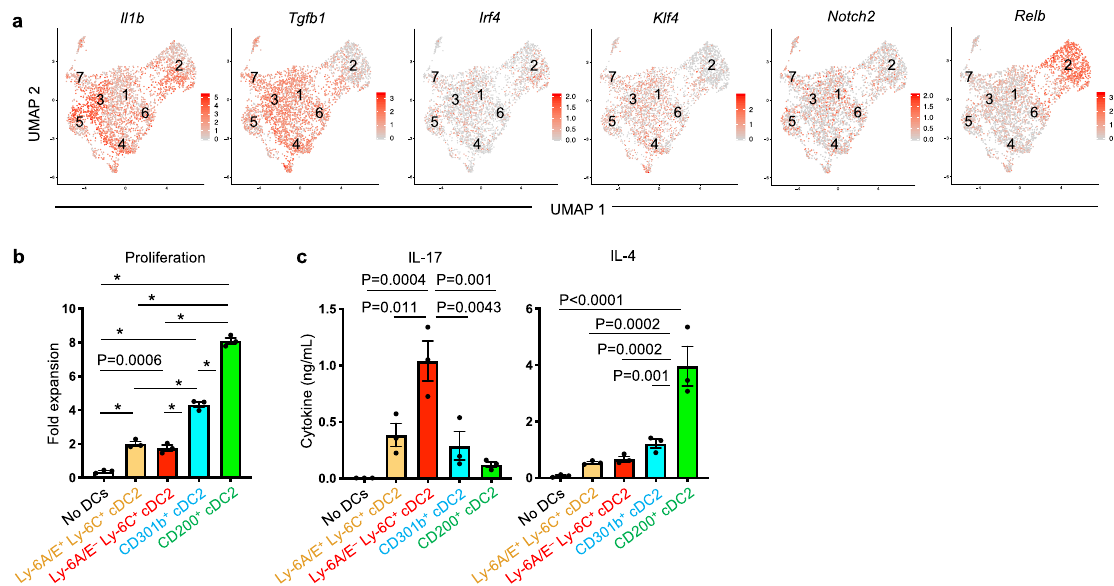
Fig. 8 Select CD11b + cDC2 subpopulations stimulate Th17 differentiation. a UMAP plots showing expression of genes encoding factors potentially regulating Th2 or Th17 cell differentiation in cDC2 clusters analyzed by scRNA-Seq. Expression levels are indicated by color difference and bars. b , c Proliferation ( b ) and IL-17 and IL-4 production ( c ) of OT-II CD4 + T cells stimulated by the indicated cDC2 subpopulations. The gating strategy for cDC sorting is shown in Supplementary Fig. 14a. Data were analyzed by ordinary one-way ANOVA with Tukey ’ s multiple comparison test ( n = 3). * P < 0.0001. Data are presented as mean ± SEM. Source data are provided as a Source Data fi